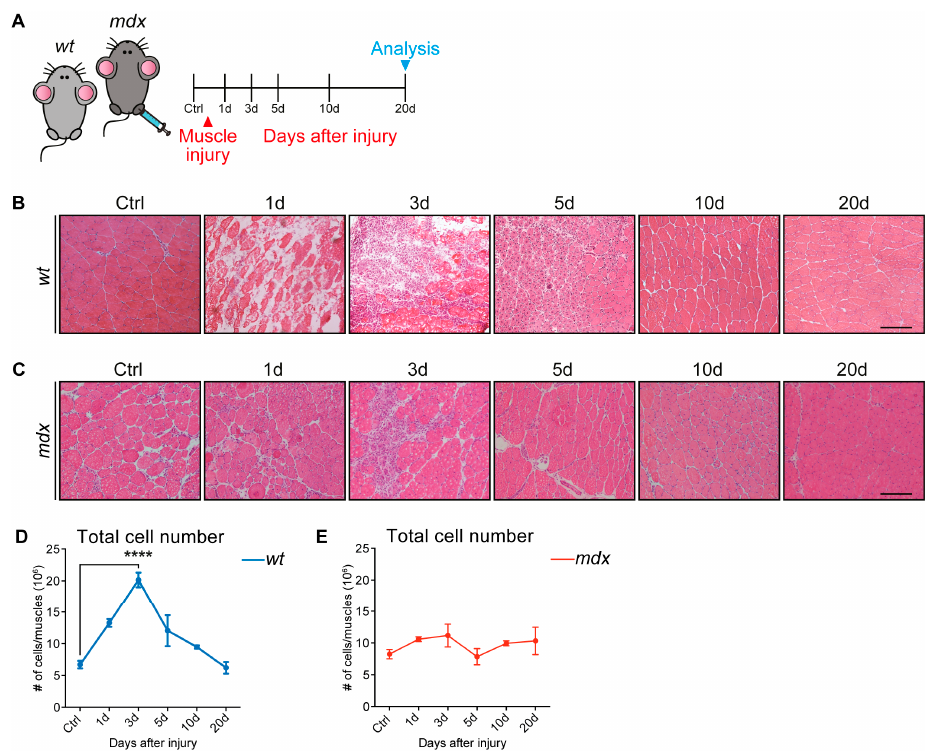
Figure 1. Cardiotoxin-induced injury on wild type (wt) and a mouse model of Duchenne muscular dystrophy (mdx) skeletal muscle tissue. ( A ) Experimental procedure. 45-day-old wt and mdx mice were injected intramuscularly with cardiotoxin (CTX) (10 μ M), and the skeletal muscles were analyzed 1, 3, 5, 10, and 20 days (d) after injury. ( B ) Representative hematoxylin and eosin staining of uninjured wt tibialis anterior (TA) muscles and regenerating wt TA muscles at 1, 3, 5, 10, and 20 days after intramuscular CTX injection. Regenerating muscles were characterized by centrally located nuclei at day 5, but reconstituted multinucleated myofibers by day 10. ( C ) Representative hematoxylin and eosin staining on histological sections of uninjured and regenerating mdx TA muscles at 1, 3, 5, 10, and 20 days after intramuscular CTX injection. All along the considered time points, mdx muscles were characterized by infiltrating inflammatory interstitial cells and centrally nucleated myofibers of different sizes. ( D , E ) The number of cells (in millions) extracted from uninjured and CTX-injured wt ( D ) and mdx ( E ) mice (n=3; for 5d wt time point, n=2). All data were represented as mean ± SEM, and the statistical significance was estimated by two-way ANOVA (**** p < 0.0001). ( B , C ) 20× magnification; scale bar: 100 μ m.